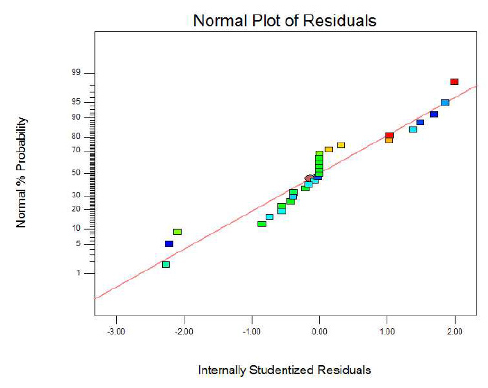
Figure 1. The studentized residuals and normal % probability plot of solar induced photocatalytic decolourization of dye ef- fluent.